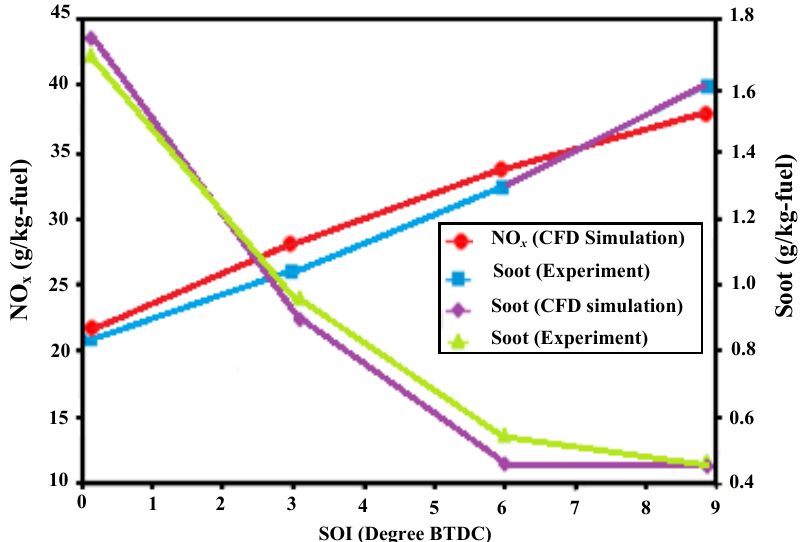
Figure 6. Influence of injection timing: comparison between predicted and measured